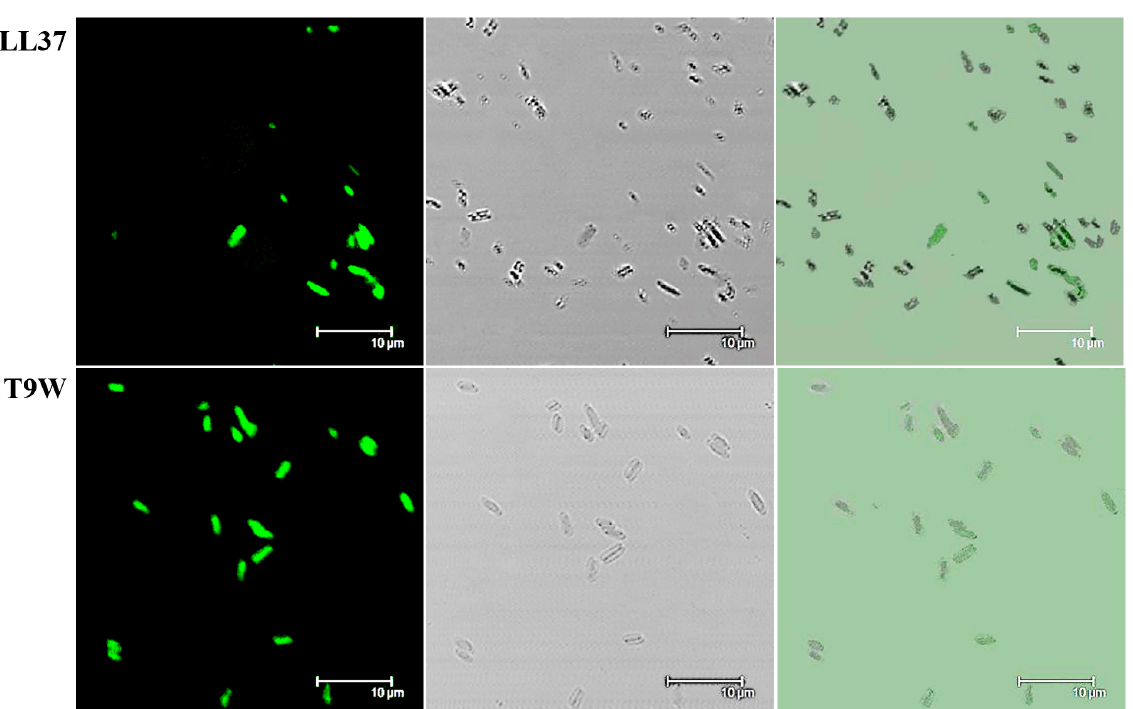
Fig. 5. Confocal fluorescence microscopic images of P. aeruginosa 27853 cells treated with FITC-labeled peptides at 37 ˚ C for 60 min. Panels on the left, middle and right represent laser-scanning, transmitted light-scanning, and merged images of cells treated with FITC-labeled peptides, respectively.